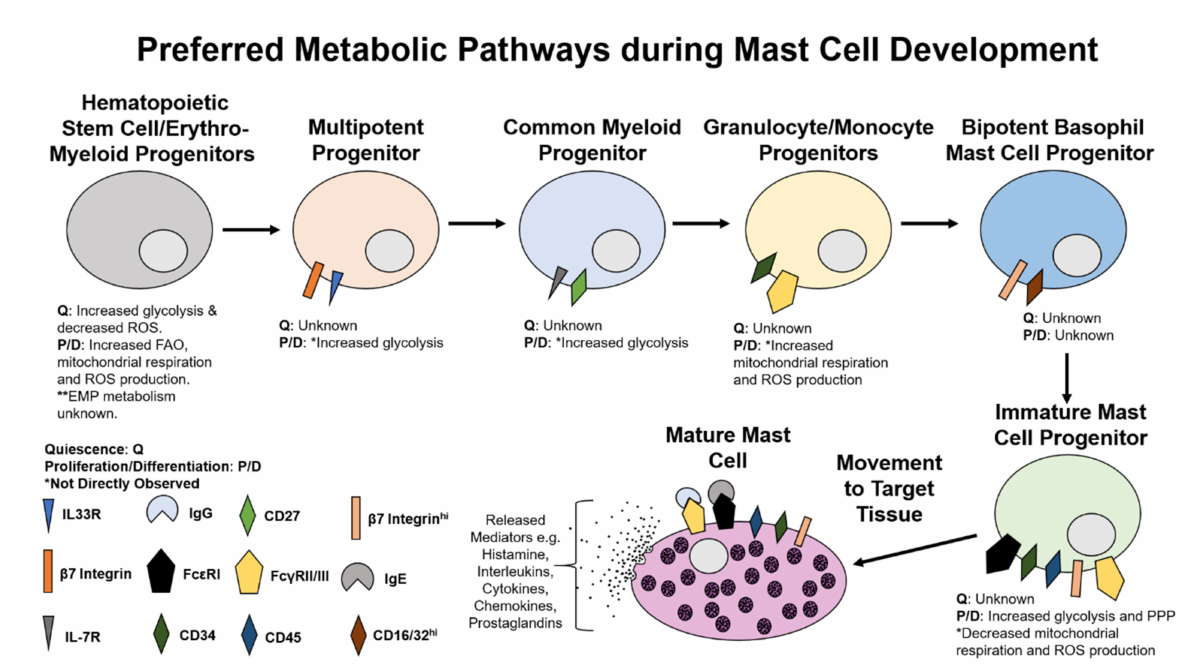
Figure 1. Preferred Metabolic Pathways during Mast Cell Development. Mast cells originate in the bone marrow as hematopoietic stem cells developing via multipotent progenitors, common myeloid progenitors, granulocyte/monocyte pro- genitors, immature mast cell progenitors prior to developing into fully mature mast cells in the target tissues. The metabolism at each developmental stage is described during both quiescence (Q) and differentiation/proliferation (P/D). Some of the preferred metabolic pathways were not directly observed (*) due to no direct experimental analysis having been performed on the metabolic pathways. The proposed metabolic pathways were determined through changes in known cellular signaling pathways and the effects these signaling pathways have on cellular metabolic